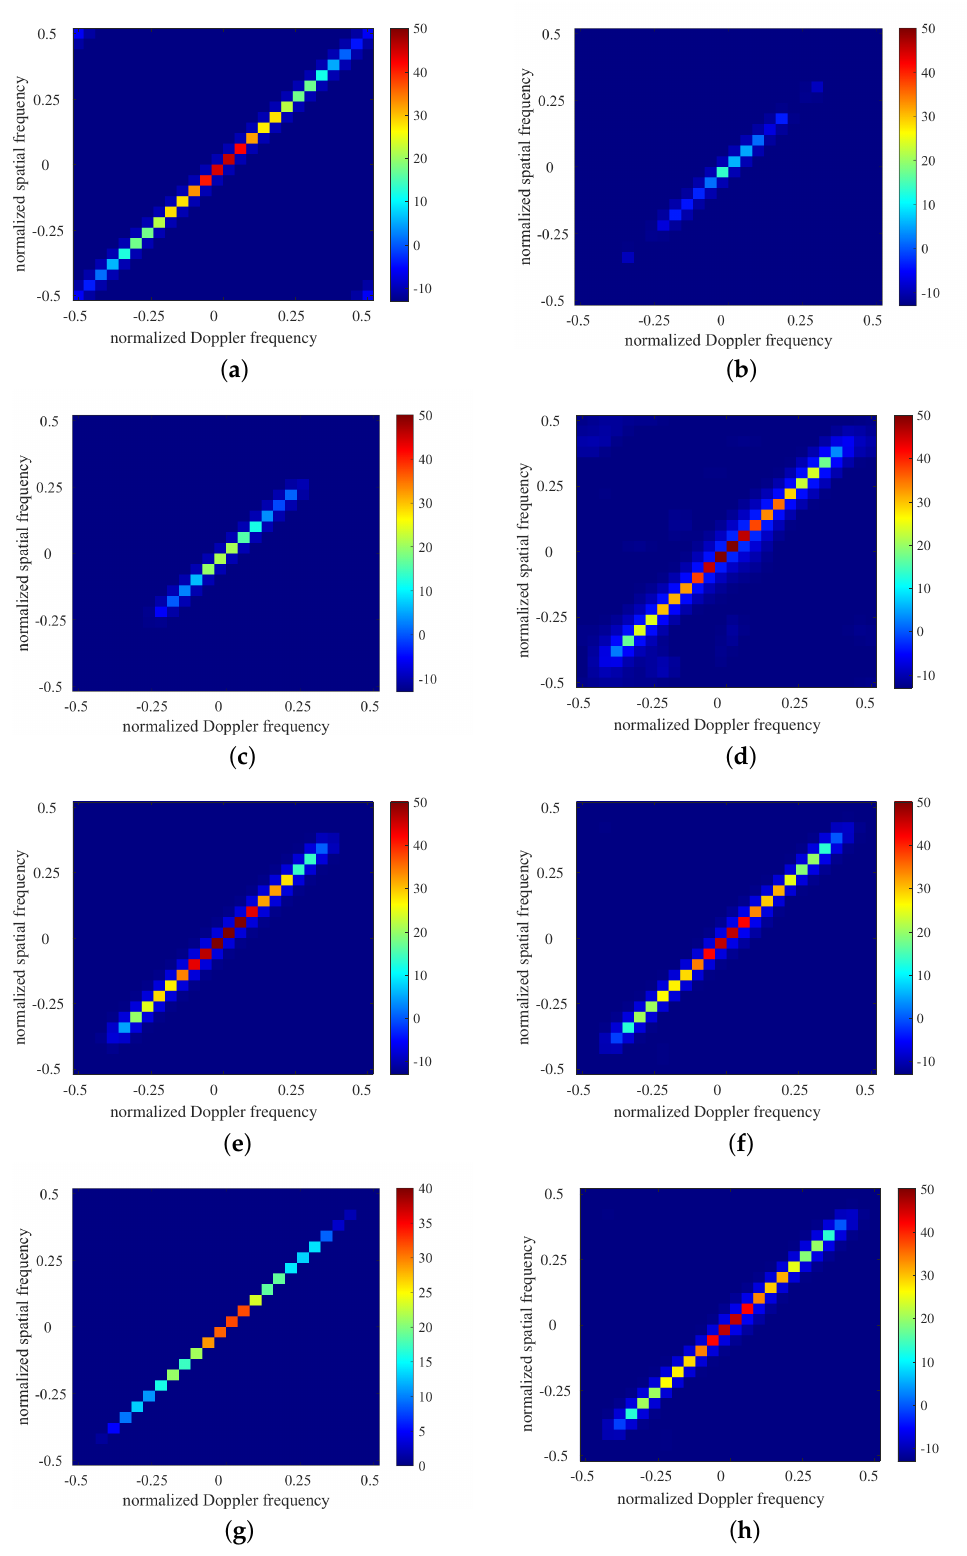
Figure 6. Estimated angle − Doppler clutter spectrum using different methods. ( a ) Clairvoyant angle − Doppler clutter spectrum. ( b ) LSMI. ( c ) M − OMP. ( d ) M − SBL. ( e ) M − FCSBL. ( f ) Clutter spectrum via MCV. ( g ) BAMCV after pre − training. ( h ) BAMCV after fine −